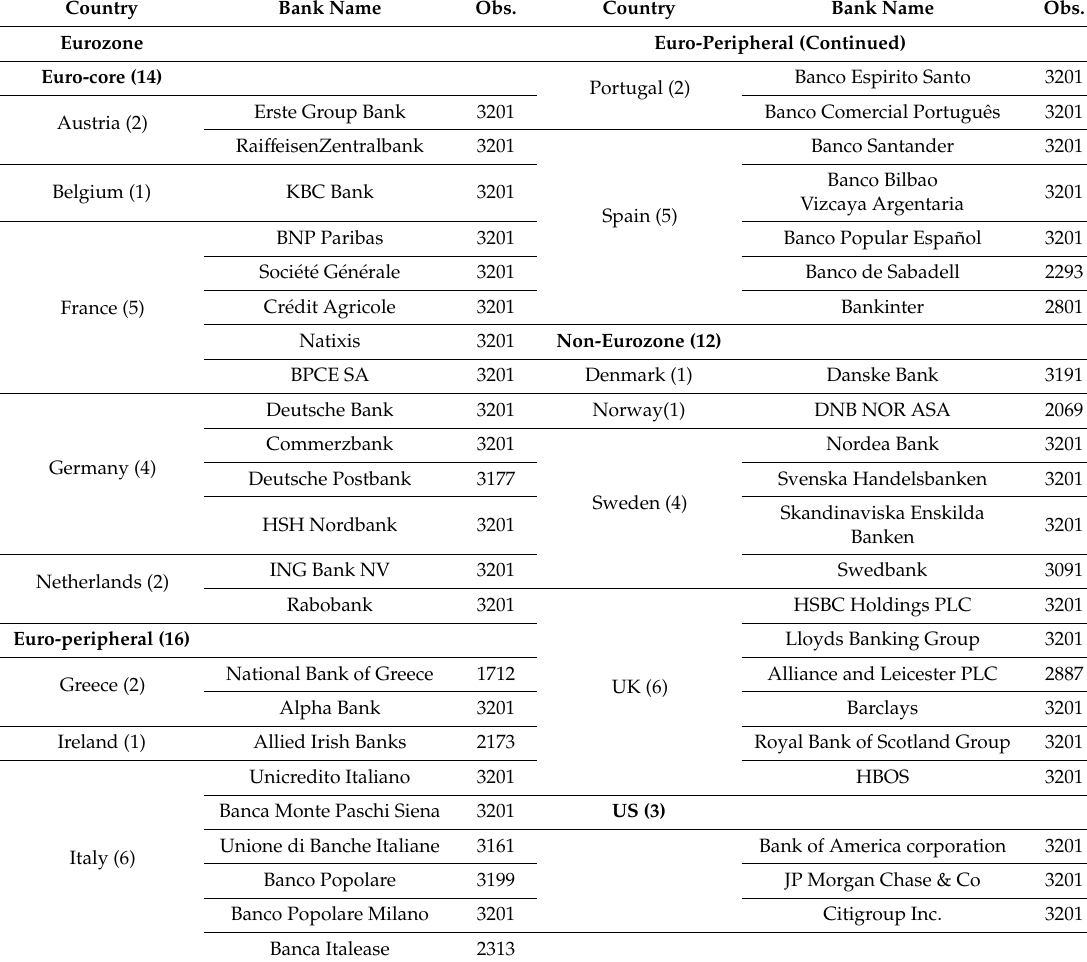
Table 4. List of European and US